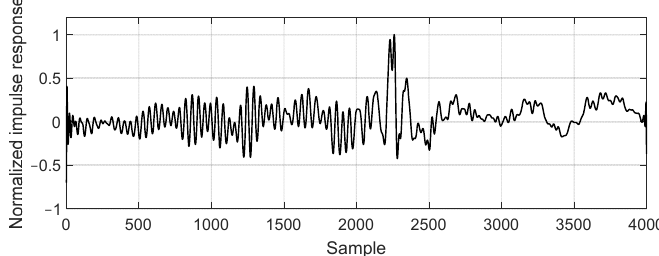
Figure 10. Impulse response of the optimal FIR inverse filter a opt